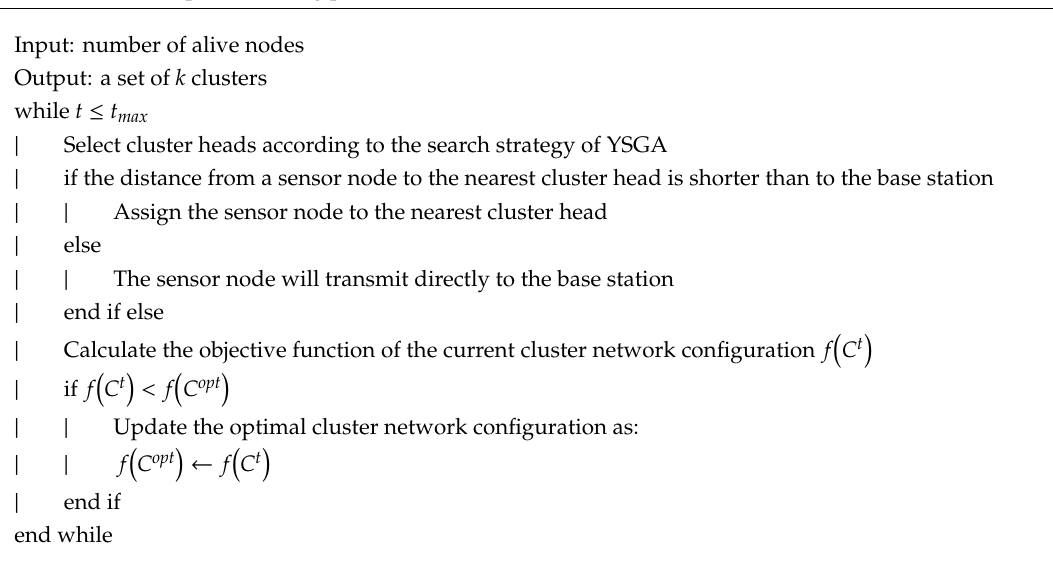
Algorithm 1. Proposed routing